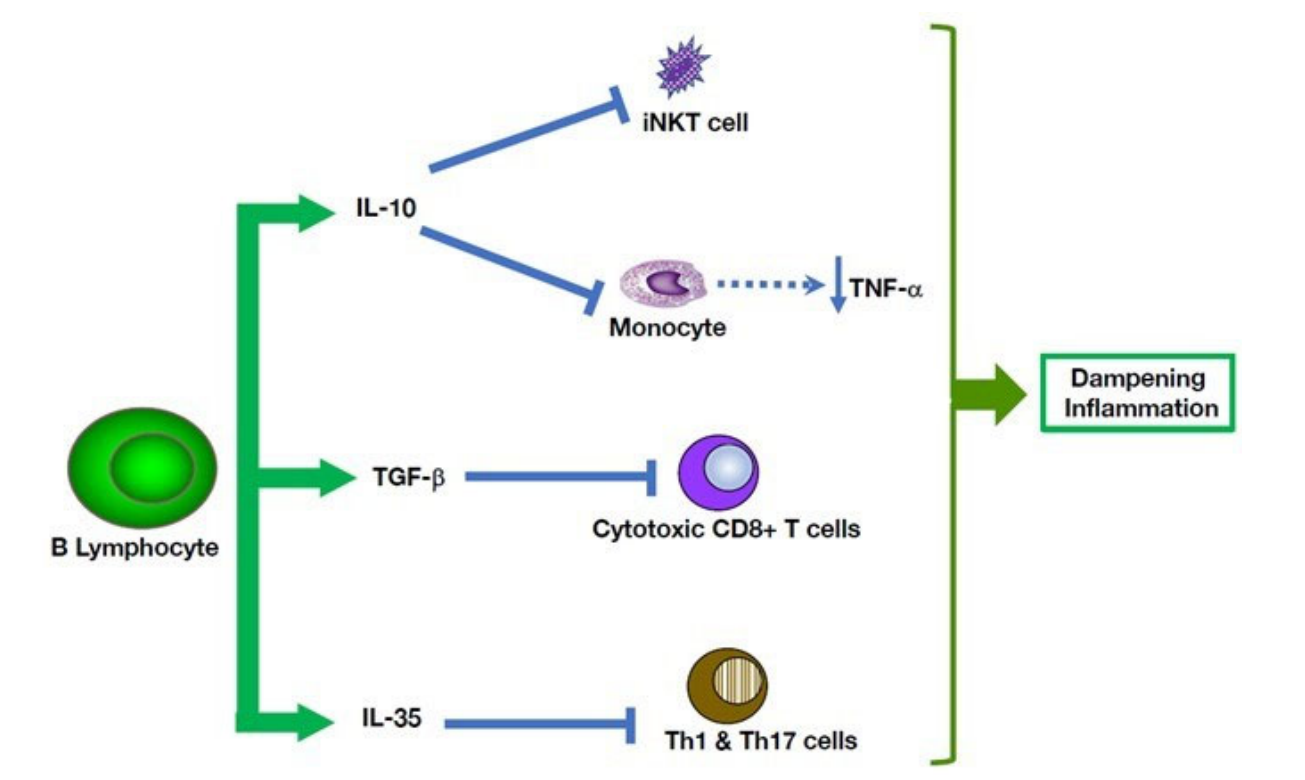
Figure 2. B cell contact-dependent mechanisms that modulate innate immunity. B cell modulating activities are not limited to cytokine production. Co-stimulatory interactions with dendritic cells or T cells can lead to immune suppression. In the innate branch of the immune system, B cells can modulate expression of invariant natural killer T (iNKT) cells through presentation of lipid antigens via the CD1d receptor, leading to expansion of inflammatory INF-gamma production.